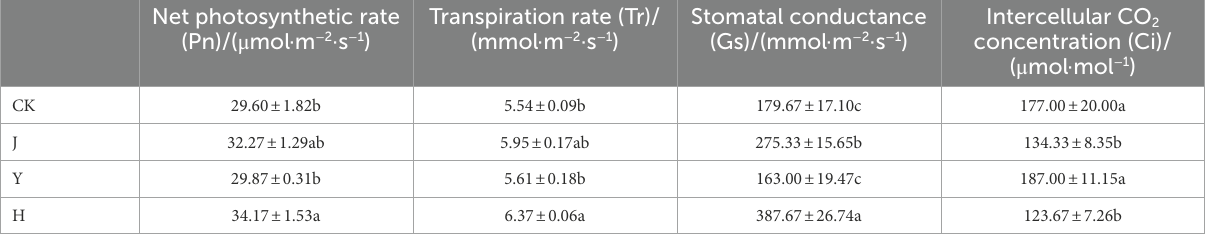
Data are means ± standard errors ( n = 3). Different letters represent significant difference at p < 0.05 (Tukey’s HSD test).